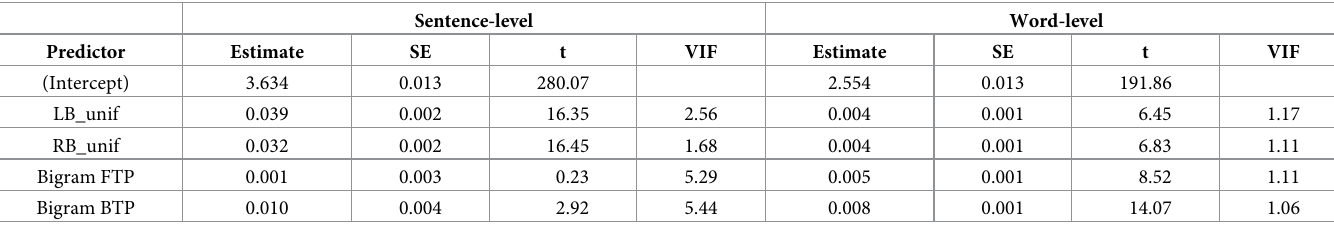
Table 9. Results of the ‘full’ model, without control